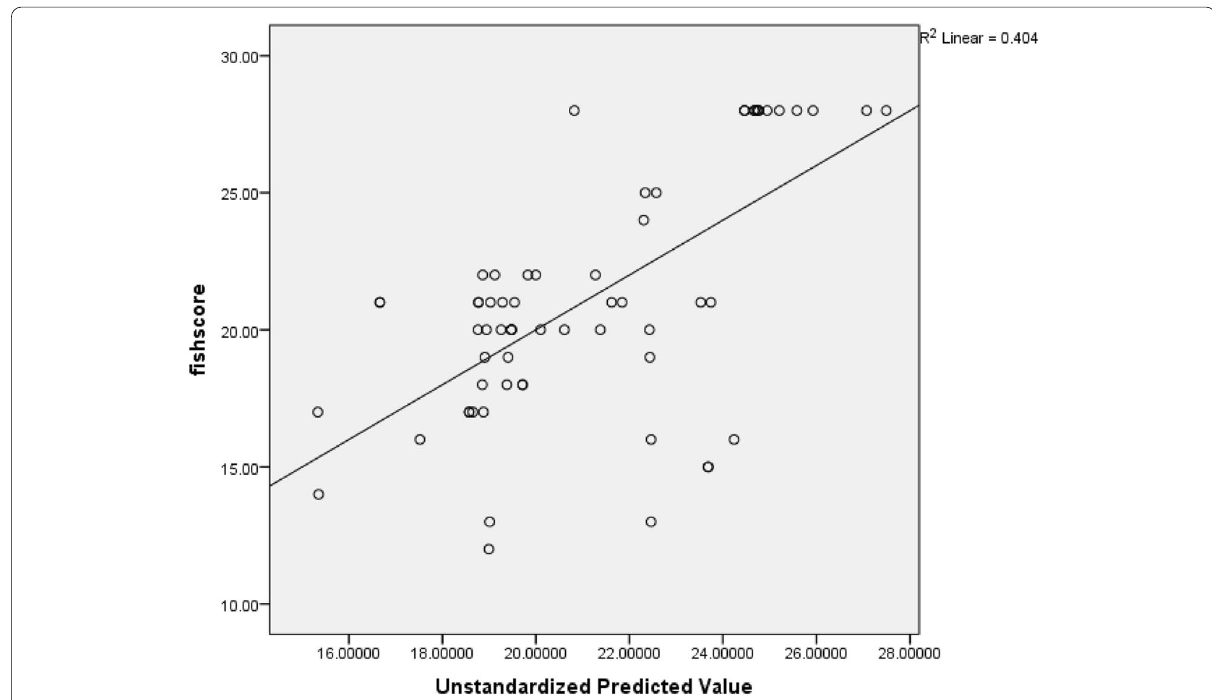
Fig. 8 Actual total FISH score versus predicted values based on the multiple regression